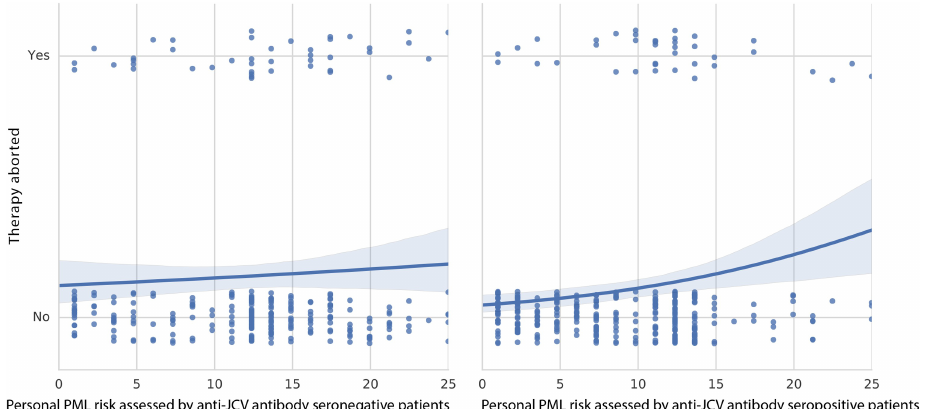
Fig 2. Relationship between patients’ assessment of personal PML risk and the proportion of patients stopping therapy. Patients’ assessment of personal PML risk on a visual analogscale from 0 to 25 points (0 = ‘low’, 25 = ‘high’)did not correlate with the proportionof patients stopping therapy in JCV Ab–patients(left side) and correlated only weakly in JCV Ab + patients (right side).